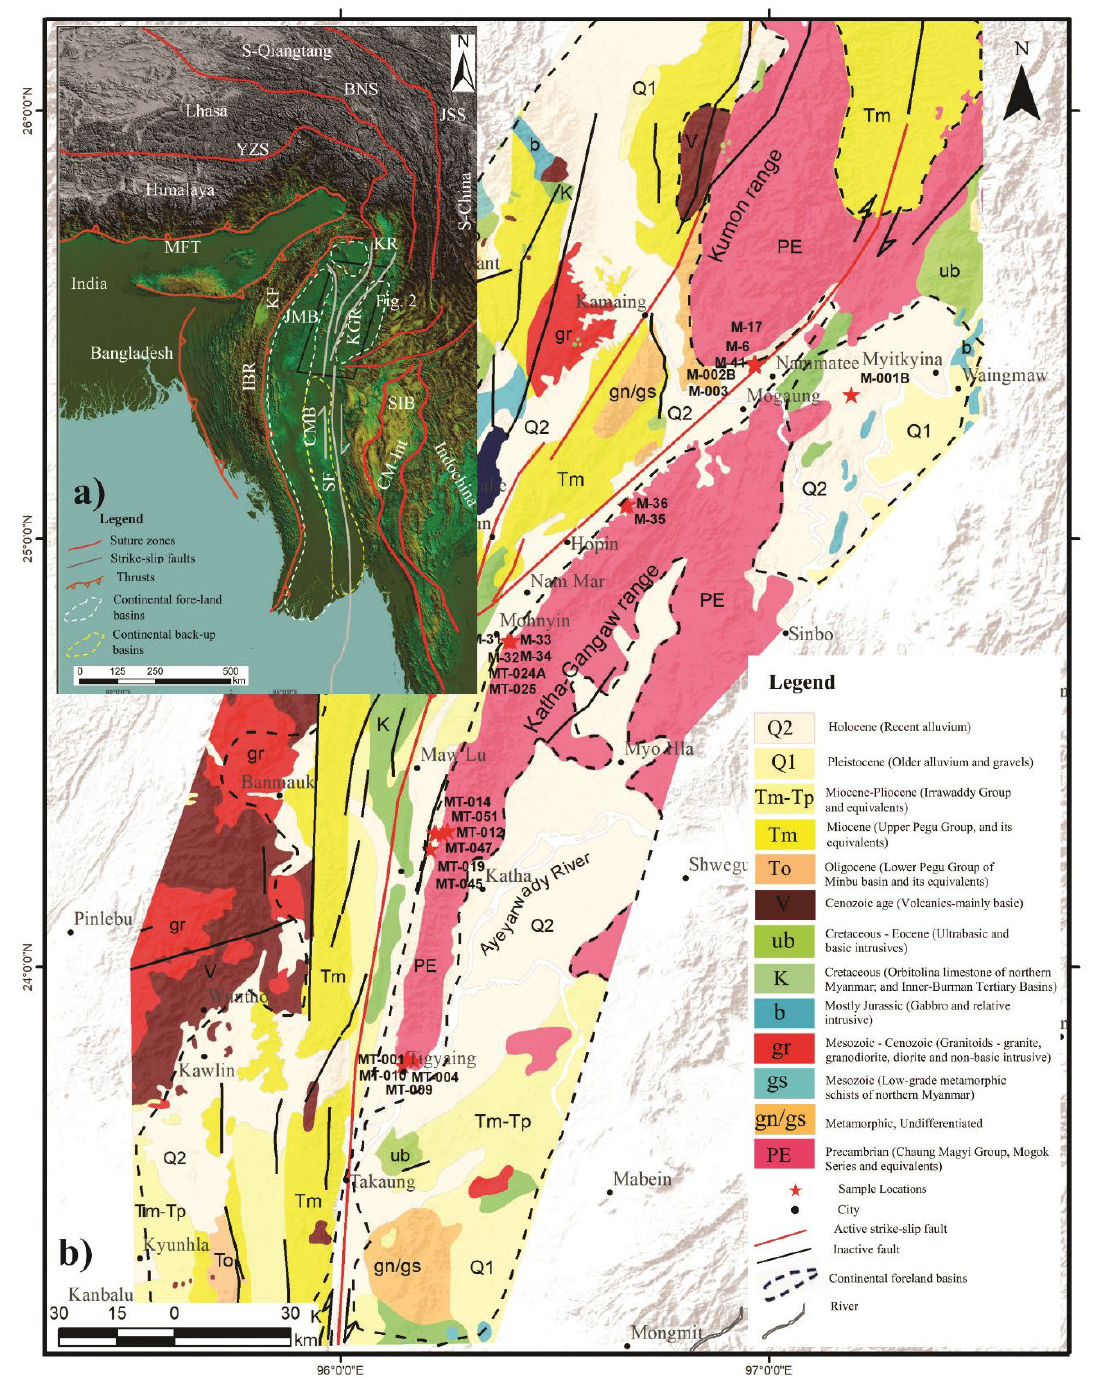
Figure 1. ( a ) Simplified geological map of India–Asia collision zone including present-day Myanmar [3,4,23,27]. CB = Central Burma, SF = Sagaing Fault, IBR = Indo-Burmar Ranges, JMB = Jade Mine Belt, KGR = Katha- Gangaw Range, KR = Kumon Range, KF = Kabaw Fault, MFT = Main Front Thrust, YZS = Yarlung Zangbo Suture Zone, BNS = Bangong-Nujiang Suture Zone, JSS = Jinsha suture zone, CM-Int = Changning–Menglian and Inthanon suture zones, SIB = Sibumasu. ( b ) Generalized geological map including the Katha-Gangaw range and the southernmost part of the Kumon range. The rectangular box in Figure 1a marks the boundary of Figure 1b.